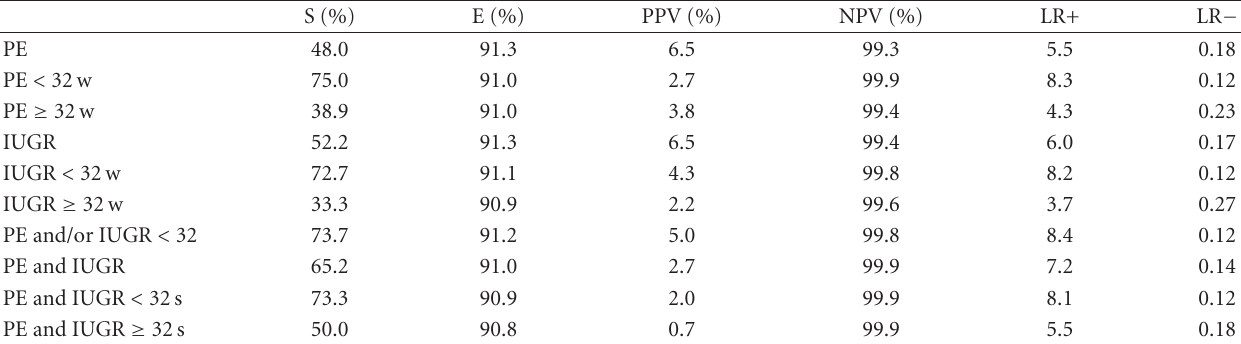
Table 2: Screening characteristics for mean PI > 1.66 and/or bilateral Notches at 20w (screen positive rate: 9.2%).